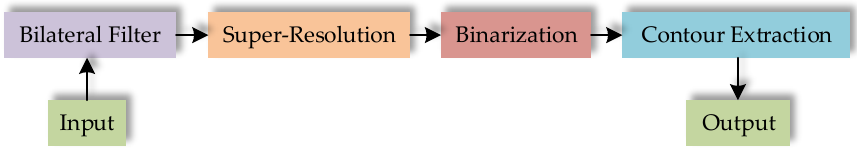
Figure 3. The process of image preprocessing. The filtering step adopts a bilateral filter, which is a nonlinear filter [26]. Two Gaussian basis functions are used to describe the spatial proximity and grayscale similarity of the image, respectively, so that the proximity relationship between the central pixel and the surrounding pixel in geometric space and the difference between pixel gray values can be considered at the same time. Therefore, the bilateral filter can preserve the edge characteristics on the premise of smooth